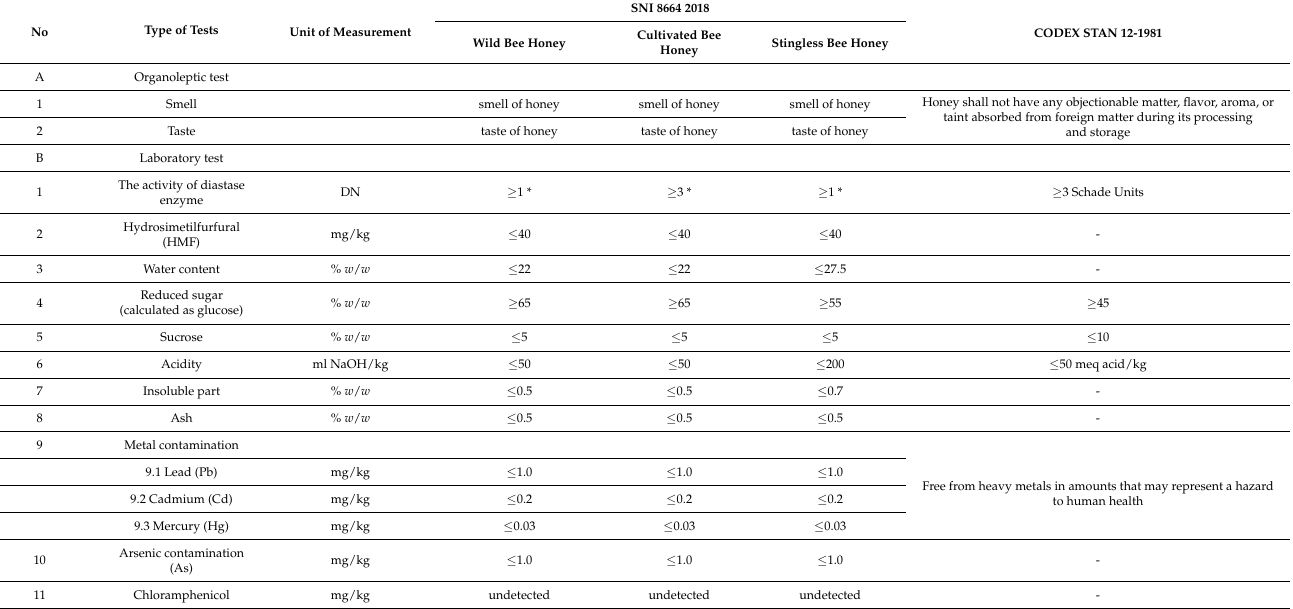
Table 5. The parameters of Indonesia and international standards concerning honey